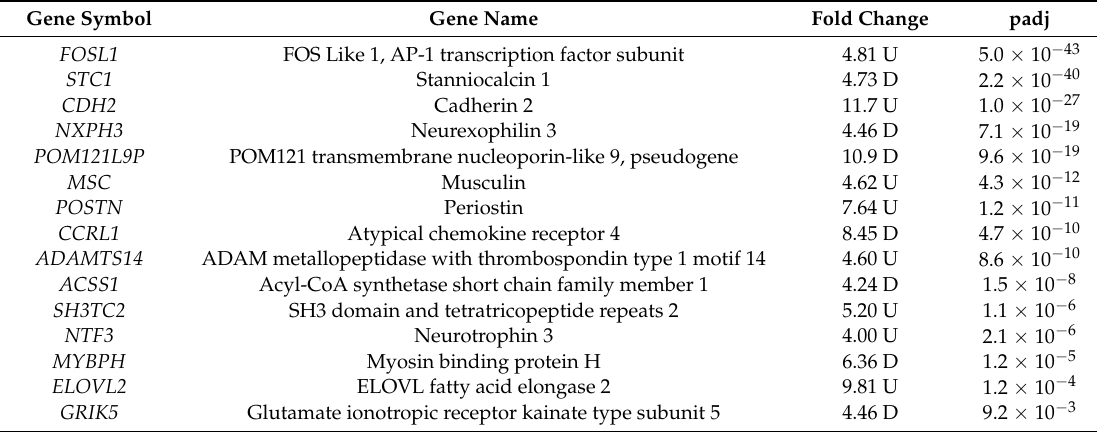
Table 5. Stable genes on SDECM (P1 vs. P4) that were differentially expressed on TCP 1 . Gene